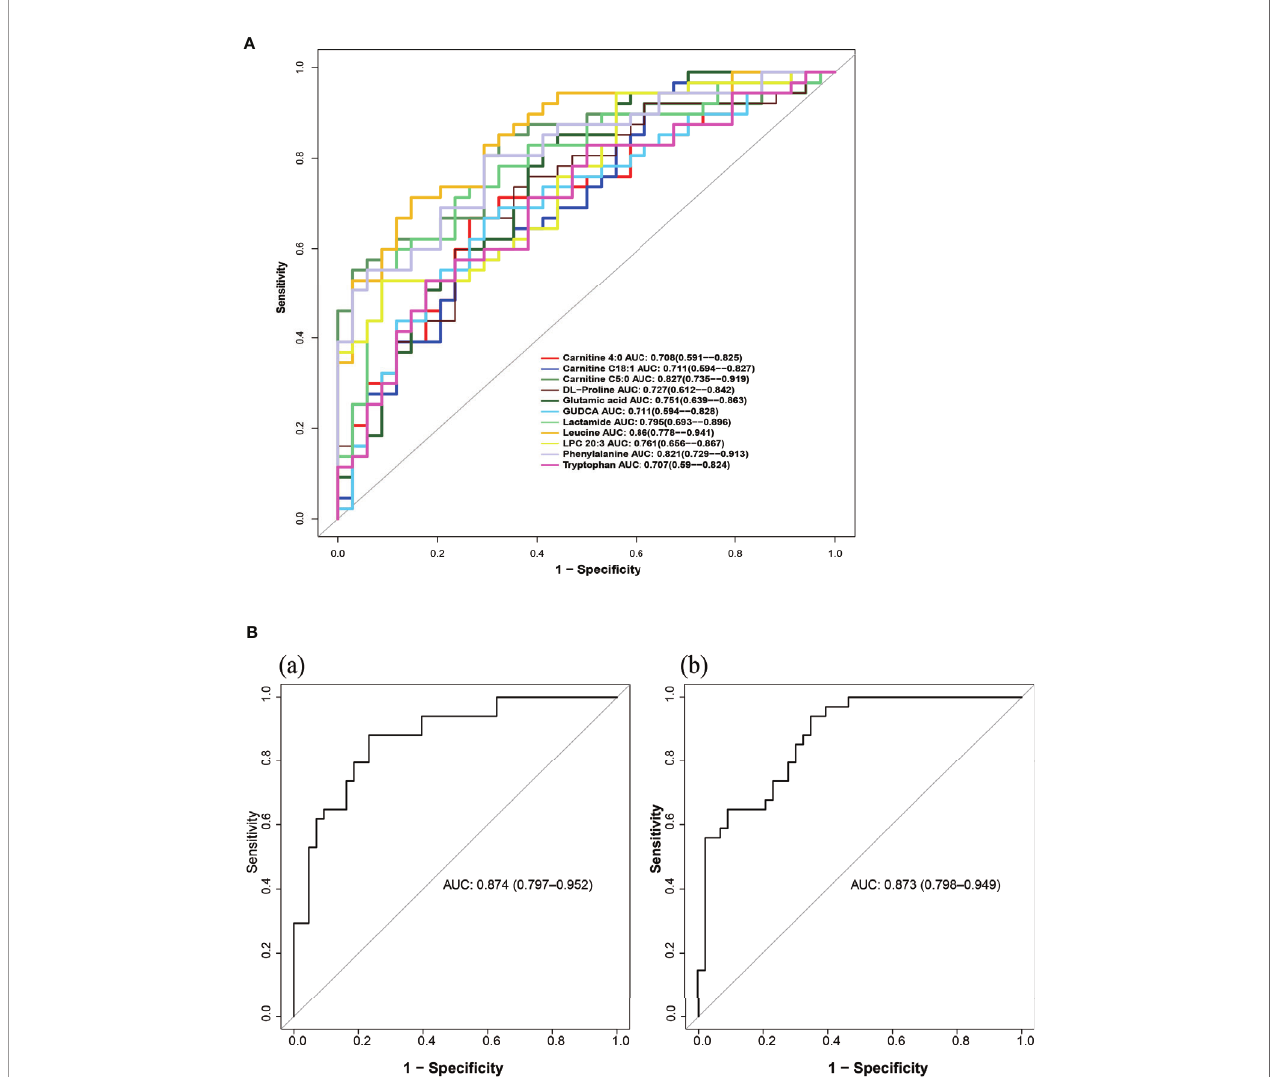
FIGURE 8 | (A) The ROC curve of single metabolites as potential biomarkers for the diagnosis of MS in patients with PCOS. (B) The ROC curves of metabolite composition as potential biomarkers, (a) glutamic acid + leucine + phenylalanine; (b) carnitine C 4:0 + carnitine C18:1 + carnitine